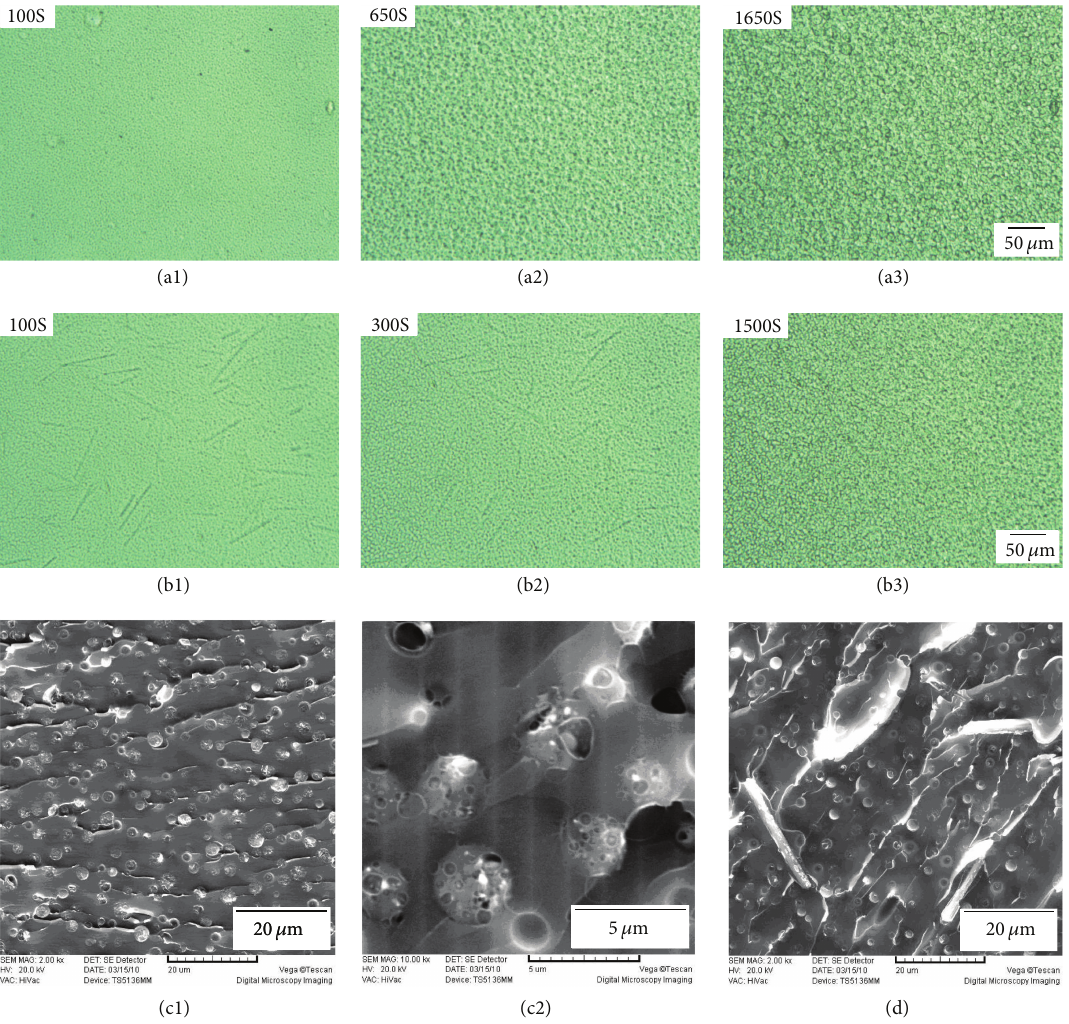
Figure5:DevelopmentofmorphologiesofthePES-11.4blendwithfillerscuredat120 ∘ CfollowedbyOMandSEMmicrographsofthefracture surface of the blend with fillers cured at 120 ∘ C for 5h. (a1)–(a3) PES-11.4-A by OM; (b1)–(b3) PES-11.4-Ca by OM; (c1) and (c2) PES-11.4-A by SEM; (d) PES-11.4-Ca by